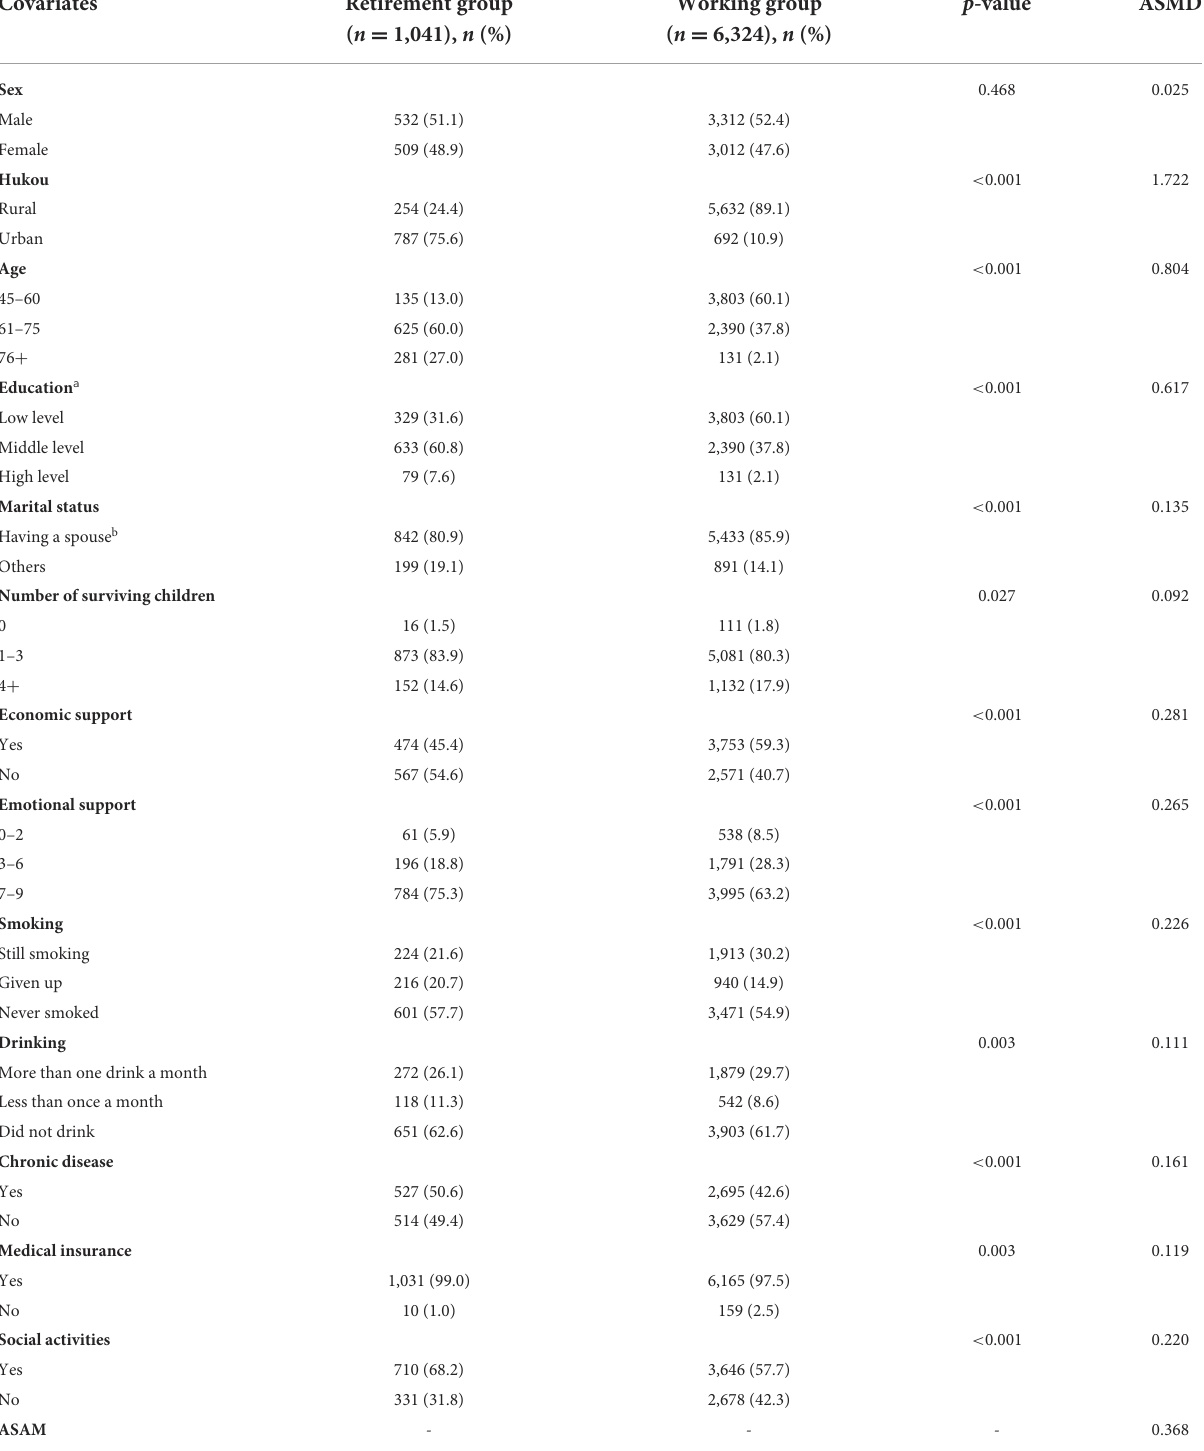
TABLE 1 Comparison of the baseline characteristics between the two groups before